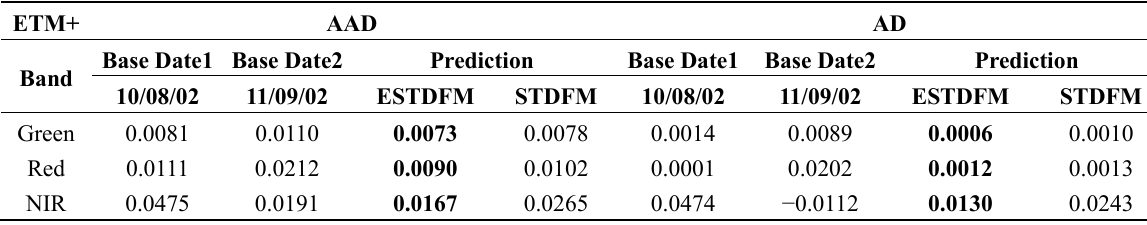
Table 3. Average Absolute Difference ( AAD ) values and Average Difference ( AD ) values between the observed reflectance at two base dates (8 October 2002 and 9 November 2002), the predicted reflectance for 24 October 2002 by different algorithms (ESTDFM or STDFM) and the observed reflectance on 24 October